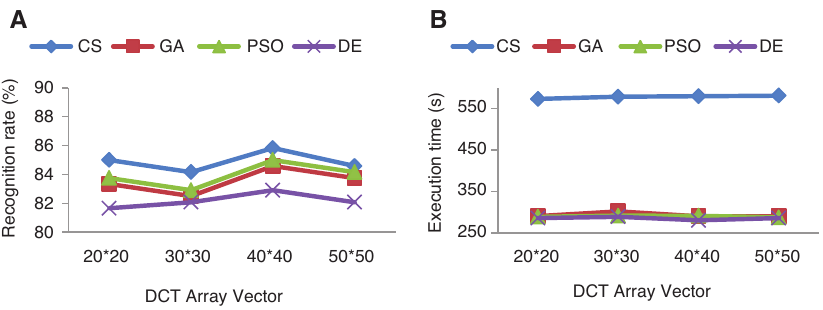
Figure 8: (A) Recognition Rate and (B) Execution Time for Dimensions of Various DCT Feature Vectors for ORL Case 2.